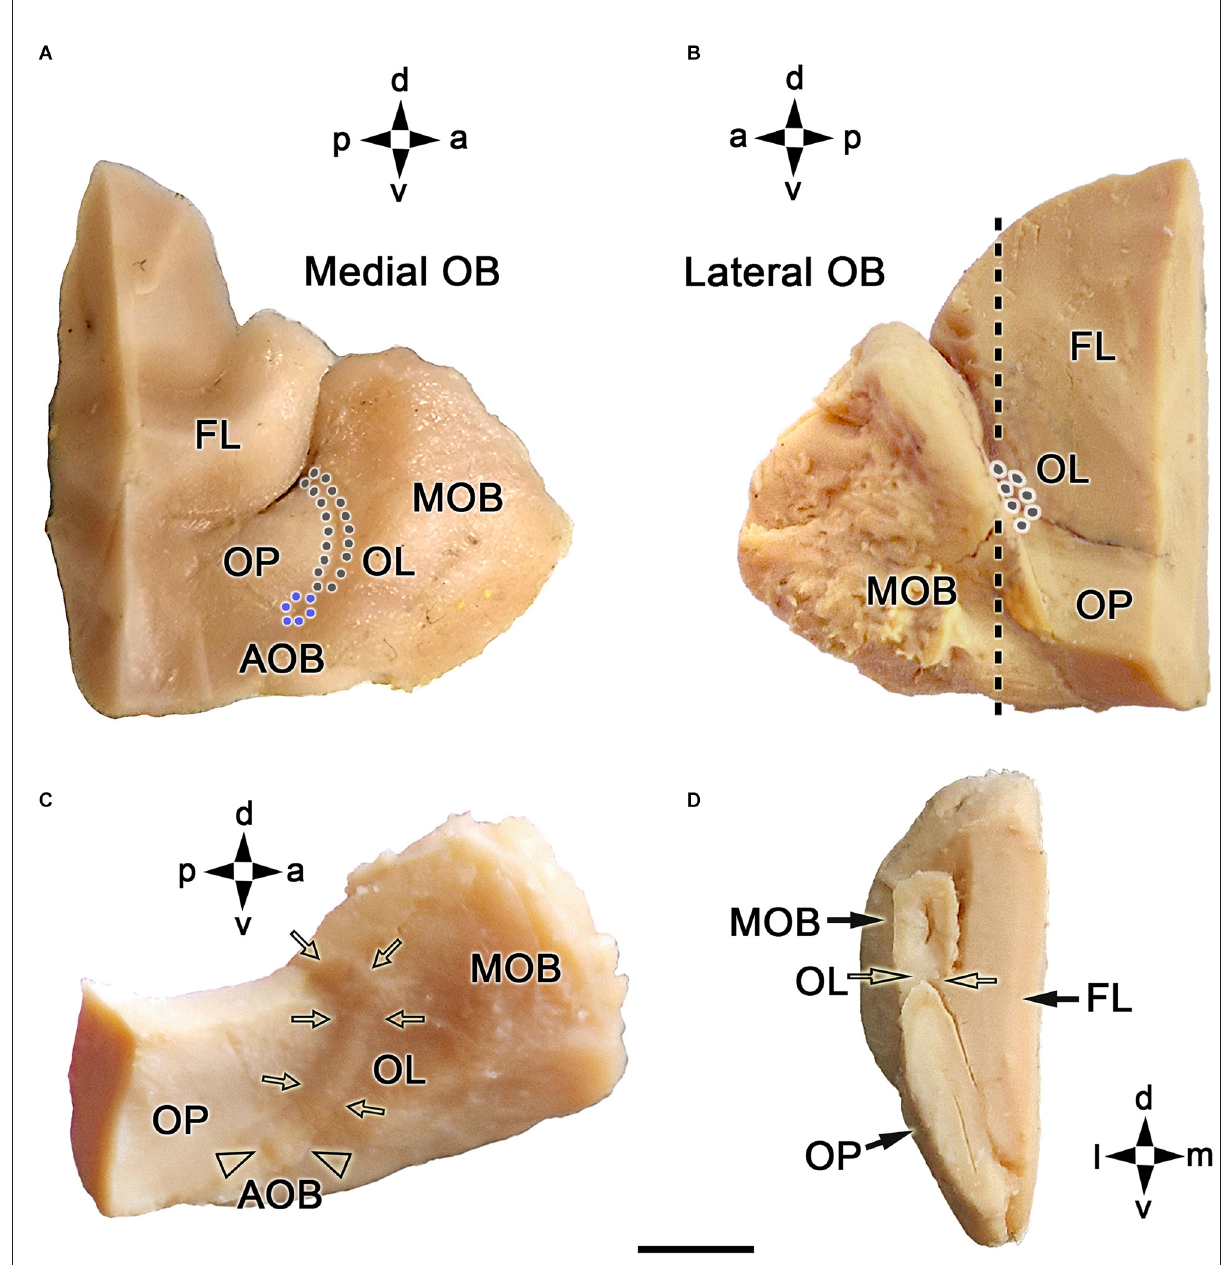
FIGURE1 Macroscopictopographicalanatomyofthefoxolfactorylimbus(OL). (A) Medialviewoftheleftmainolfactorybulb(MOB).Theolfactorypeduncle (OP) and the caudomedial margin of the olfactory bulb are visualized. The accessory olfactory bulb (AOB, blue dots) and the olfactory limbus (OL, black dots) are located along the MOB’s caudal surface. (B) Lateral view of the left main olfactory bulb. The lateral most portion of the OL is located in the caudal margin of the MOB. (C) Dorsolateral view of the right MOB after removal of the frontal lobe (FL). The entire length of the OL (arrows) and the AOB (arrowheads) can be visualized. (D) Caudal view of a transverse section of the left MOB and OP at the level depicted by a dashed line in (B) . The OL is located in the caudoventral portion of the MOB (open arrows). a, anterior; d, dorsal; l, lateral; m, medial; p, posterior; v, ventral. Scale bar: 500 µ m.